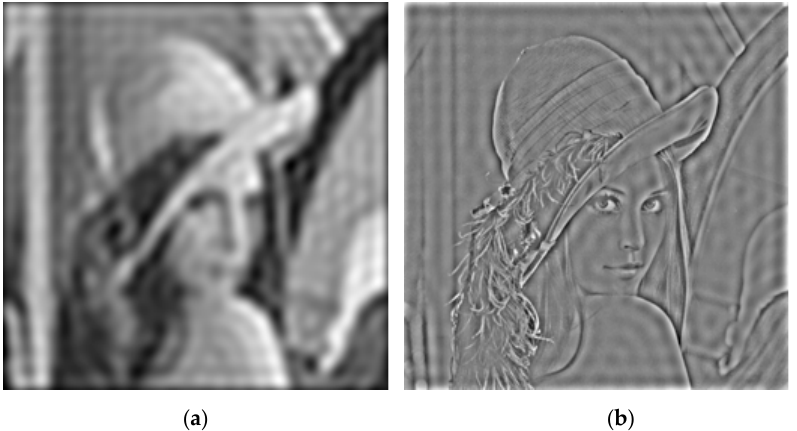
Figure 1. De-high and De-low frequency images of Lena: ( a ) low frequency components; ( b ) high frequency components.